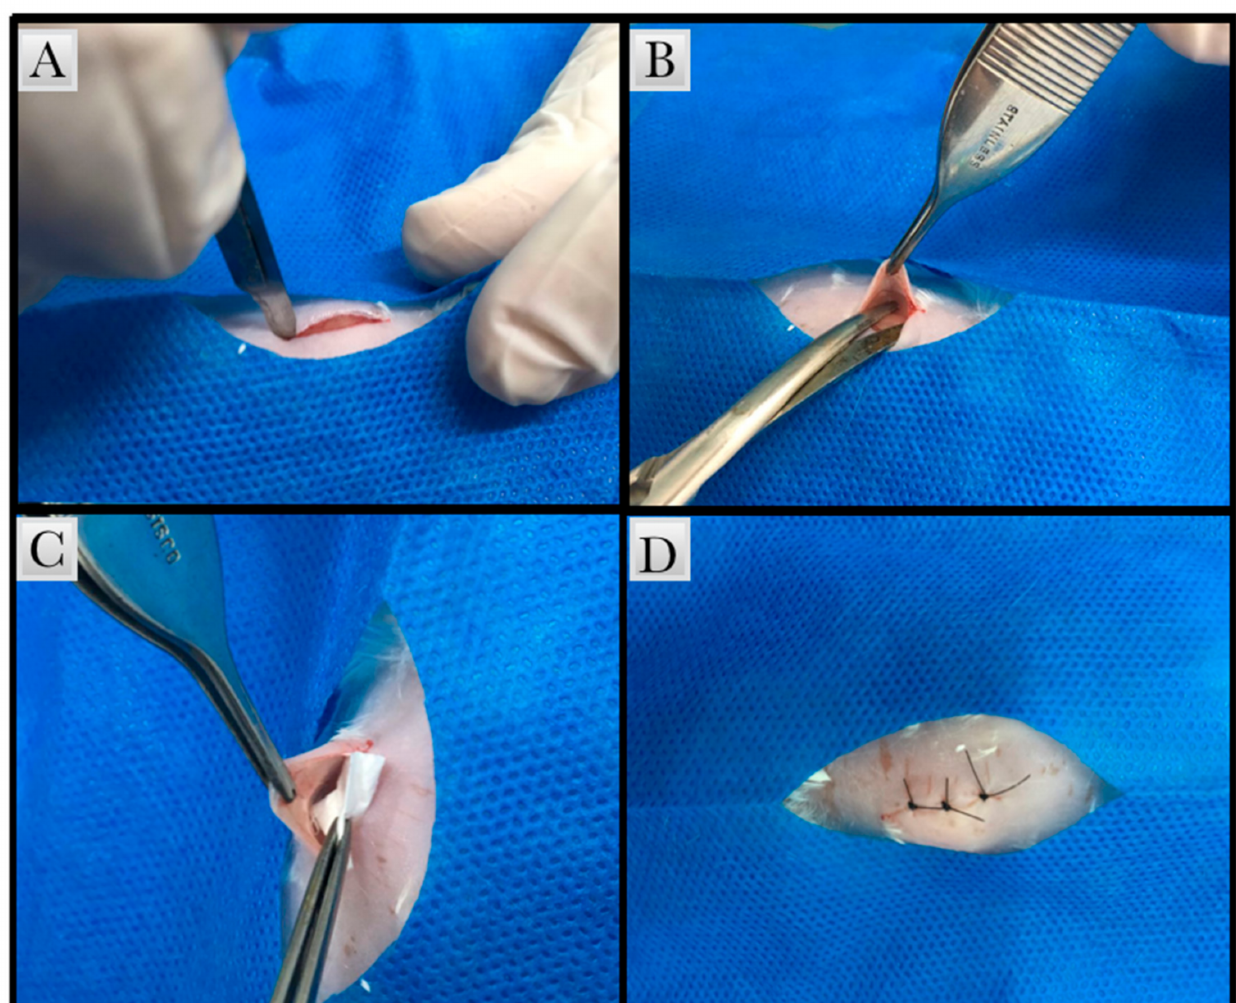
Figure 1. Surgical procedure ( A ) Subcutaneous linear incisions were made using a no. 15 C scalpel blade in the dorsal region of the animal. ( B ) Divulsion of the subcutaneous tissue was performed with a blunt-tipped scissors. ( C ) Membrane insertion ( D ) Suture of the implantation area with 5-0